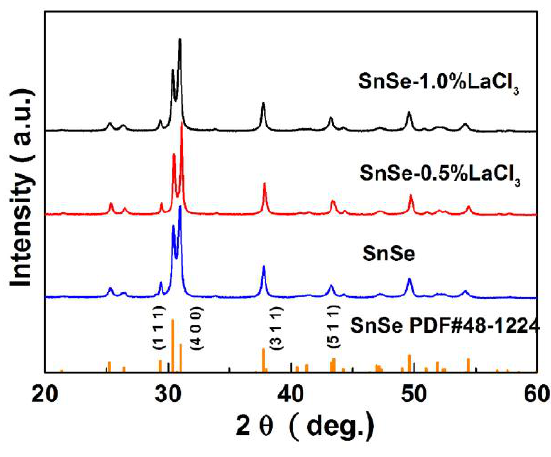
Figure 1. XRD patterns of all the LaCl 3 doped SnSe samples.